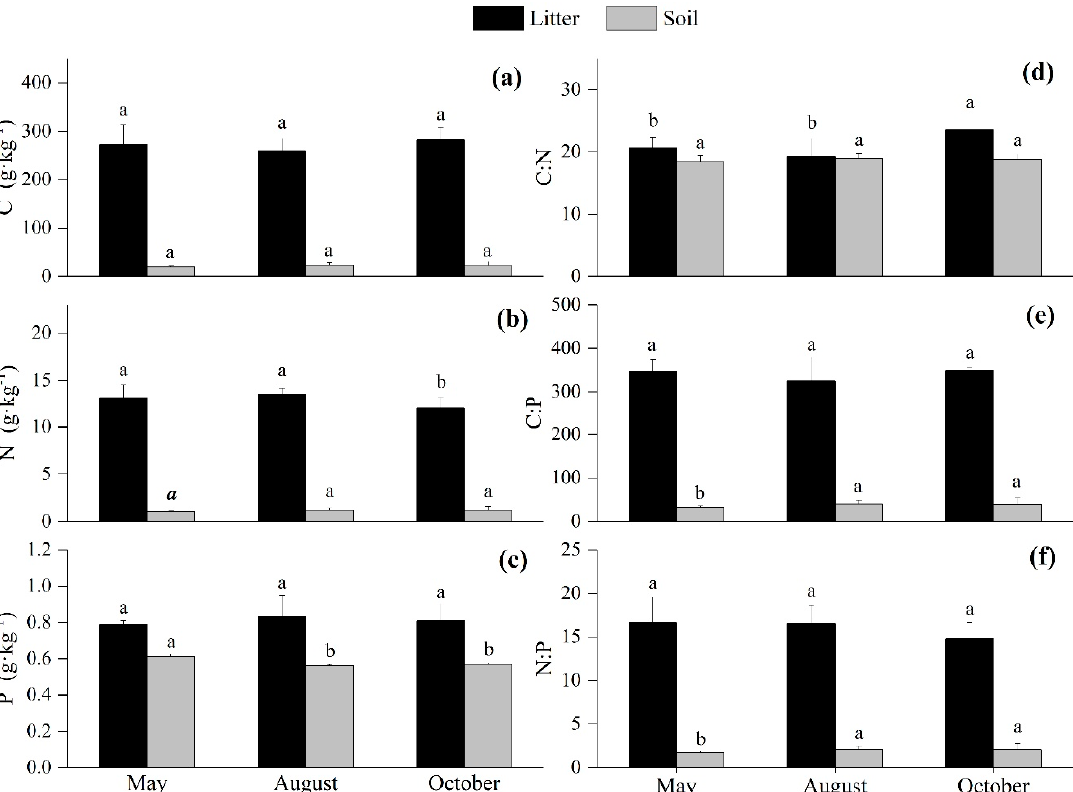
Figure 4. Seasonal variations of the C, N, and P contents and ratios in the litter and soil. ( a ) describes the C content of the litter and soil; ( b ) describes the N content of the litter and soil; ( c ) describes the P content of the litter and soil; ( d ) describes the C:N ratio of the litter and soil; ( e ) describes the C:P ratio of the litter and soil; ( f ) describes the N:P ratio of the litter and soil. Different small letters over the bars represent the significant differences among the different growing seasons at p < 0.05.